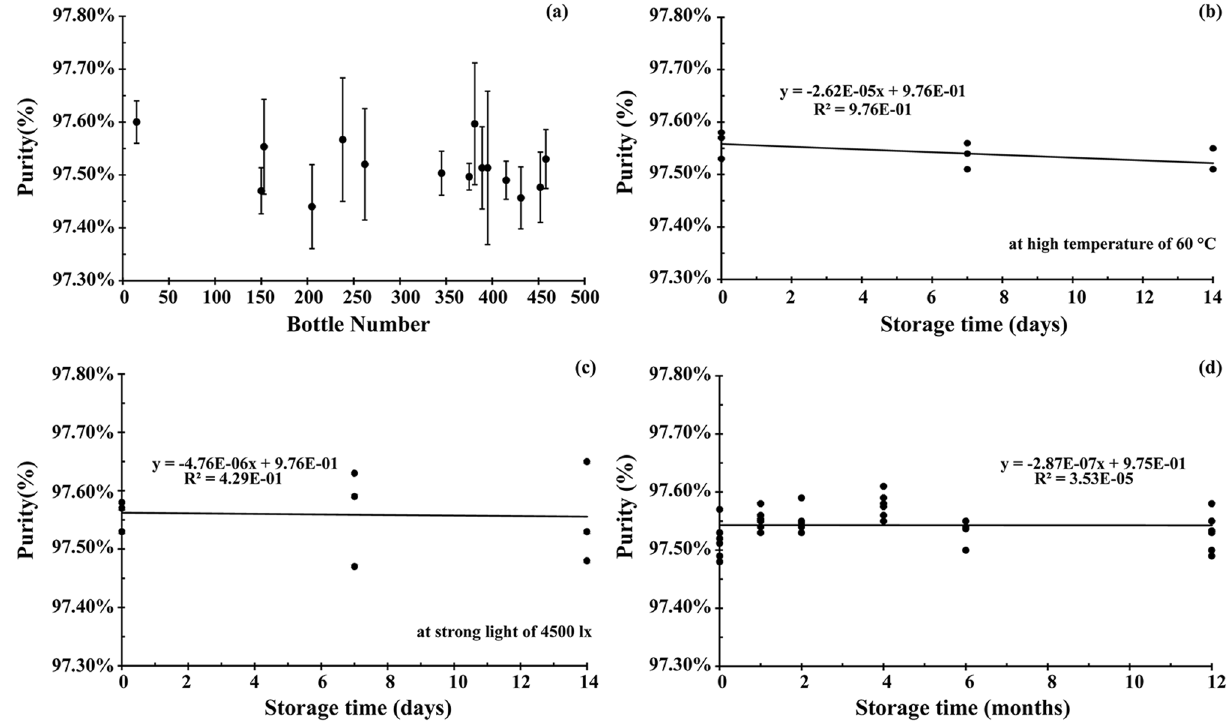
Fig. 1 Homogeneity and stability assessments of CHA candidate CRM. a Homogeneity results of the 15 randomly picked bottles (mean ± standard deviation from 3 replicate measurements). Short- term stability results of the 3 randomly picked bottles for each of the